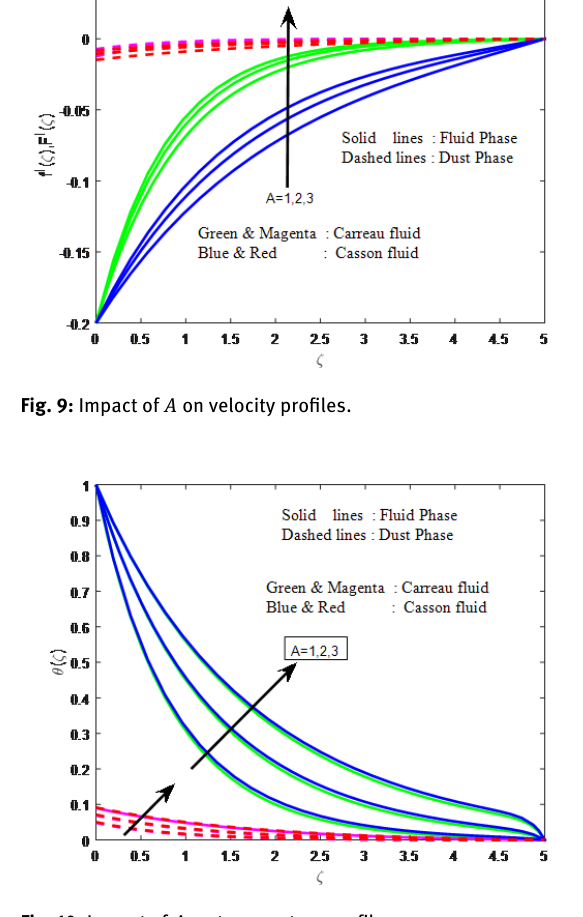
Fig. 10: Impact of A on temperature profiles.